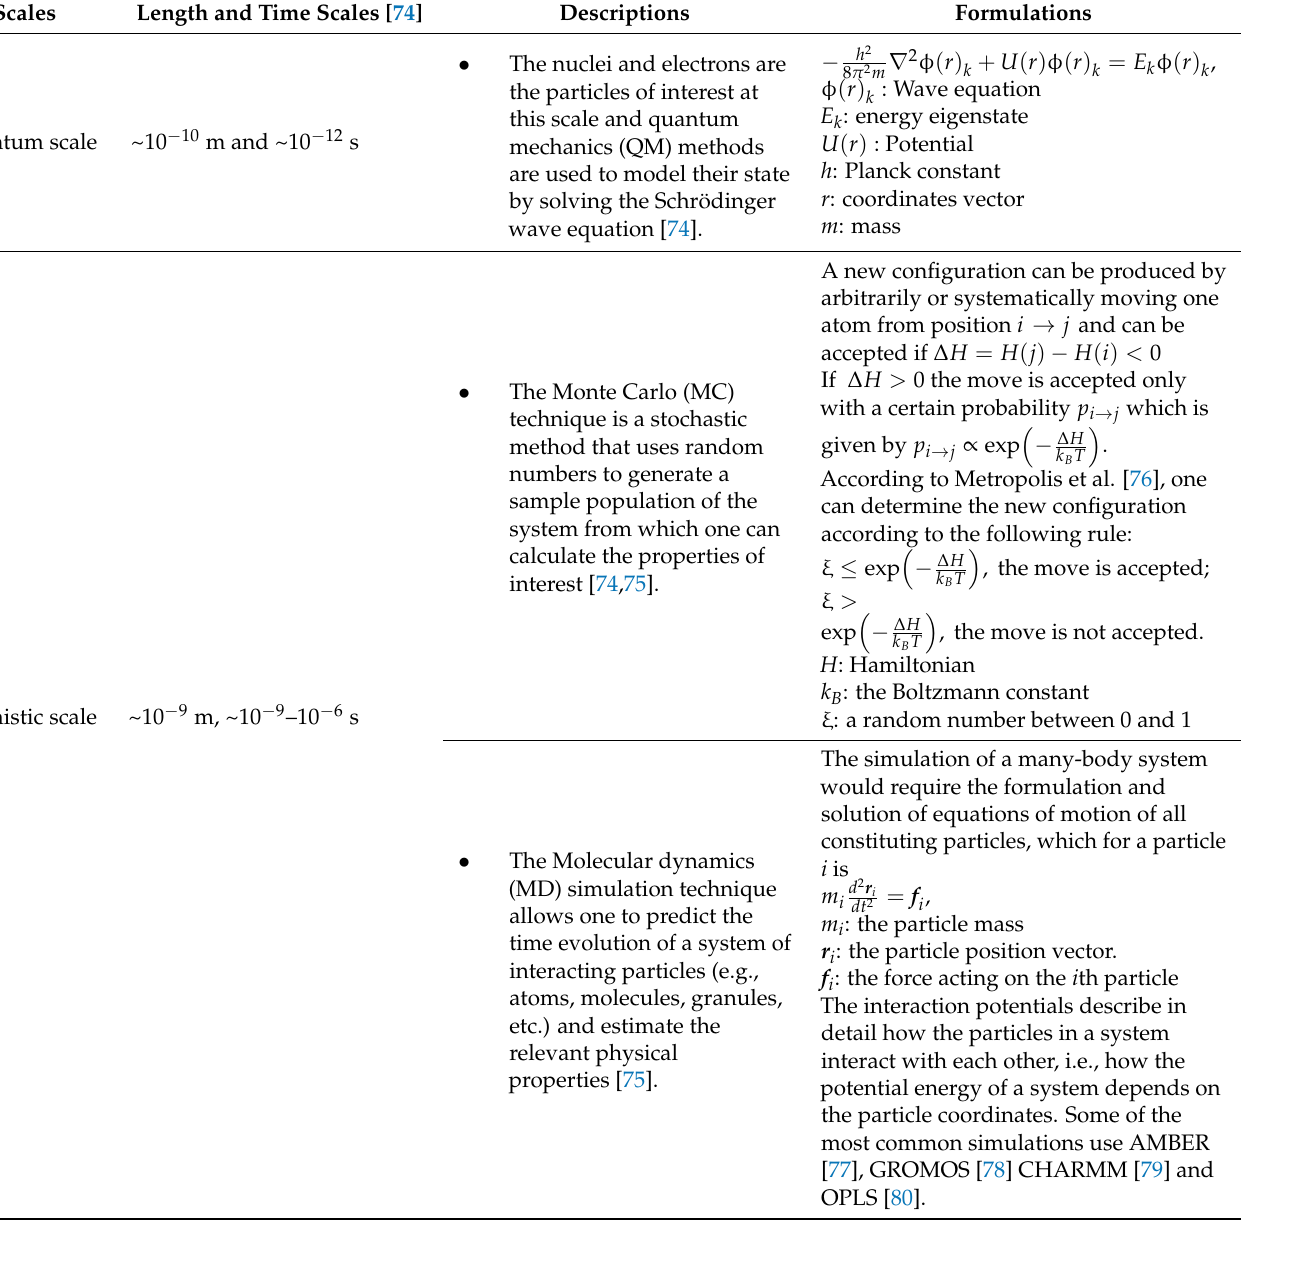
Table 1. General descriptions of the common simulation methods applied for drug-delivery studies. Scales Length and Time Scales [74] Descriptions Formulations